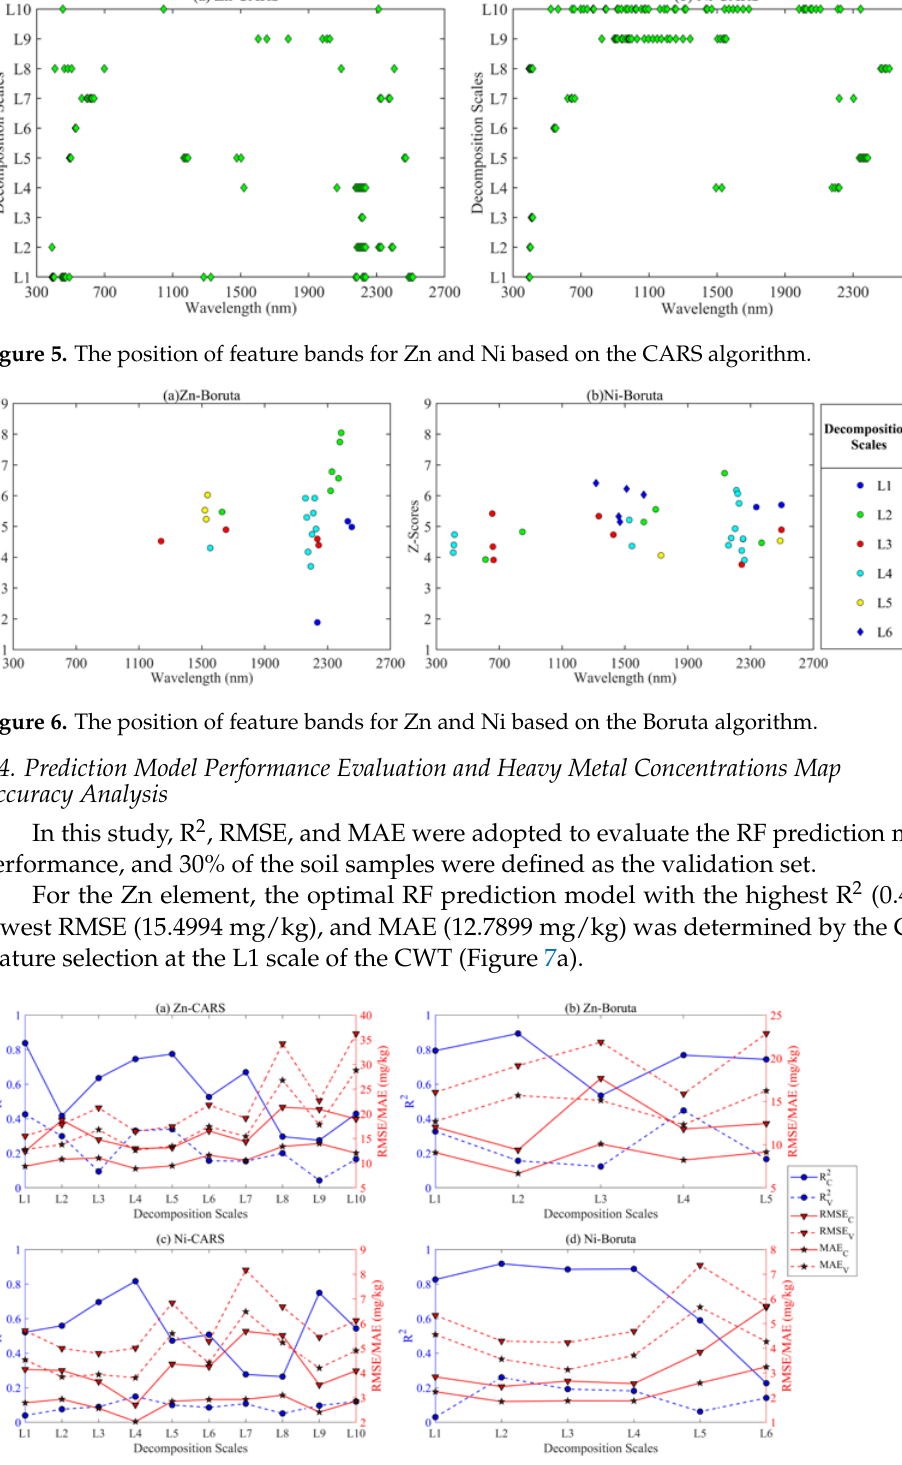
Figure 7. Evaluating RF model performance at each decomposition scale of CWT.